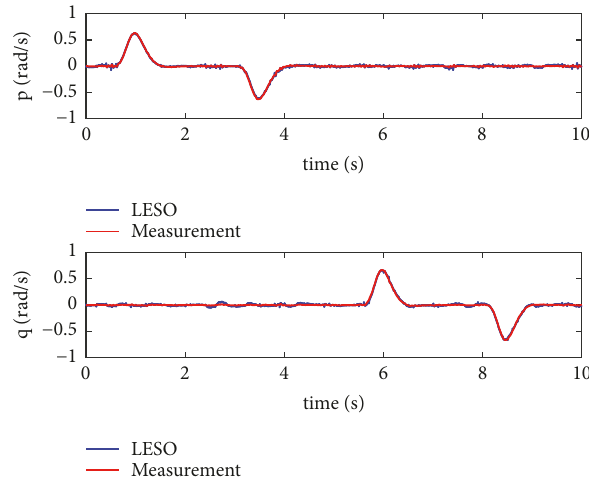
Figure 12: Performance of the